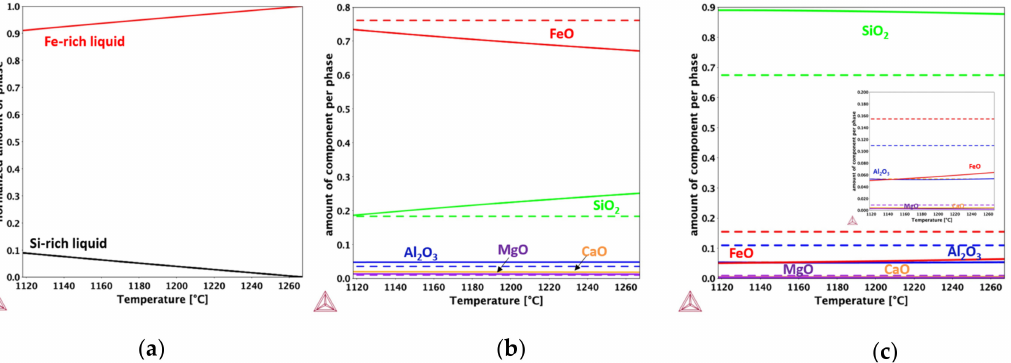
Figure 4. Temperature dependence of ( a ) phase fraction of L Si -dispersed amoeboids and composition of ( b ) Fe-rich and ( c ) Si-rich liquids. Dashed curves correspond to analytical measurements from TEM and colors correspond to different components (FeO-red, SiO 2 -green, Al 2 O 3 -blue, CaO-orange,